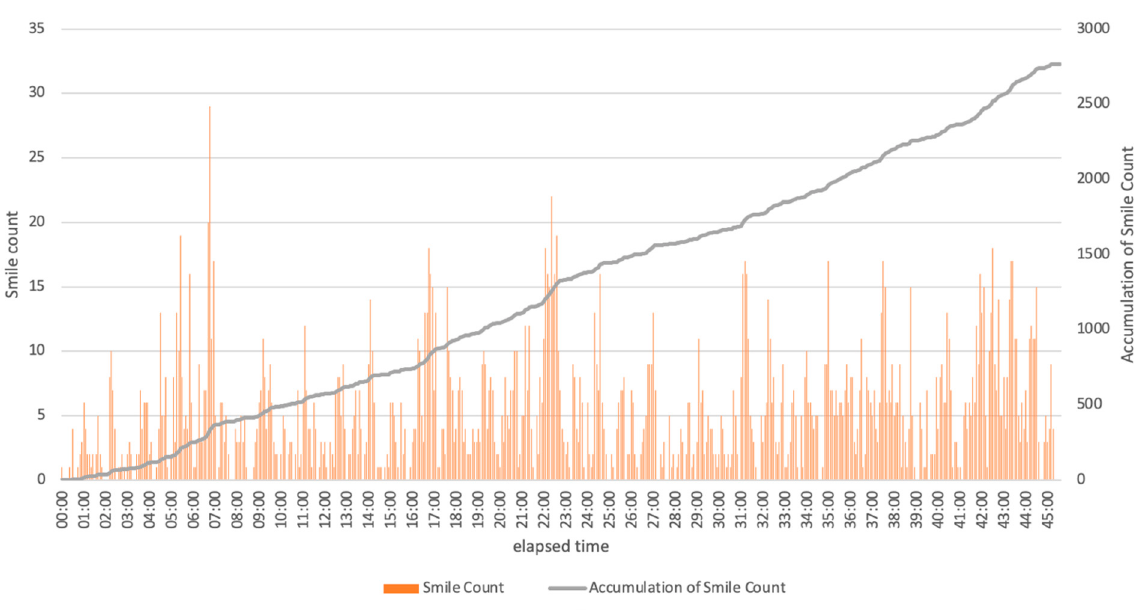
Figure 1. Relationship between elapsed time and smile